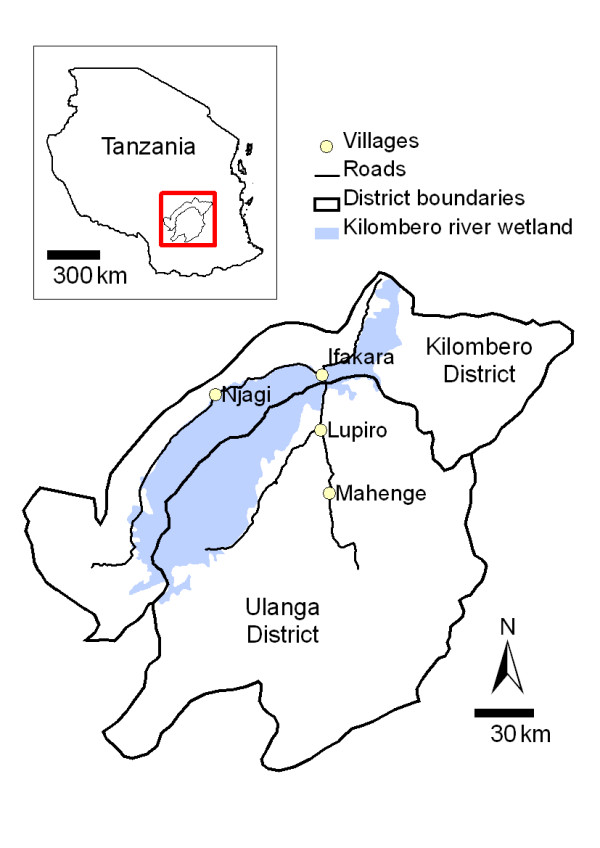
Kilombero and Ulanga districts (8.1°S and 36.6°E) in Tanzania showing Njagi and Lupiro villages.